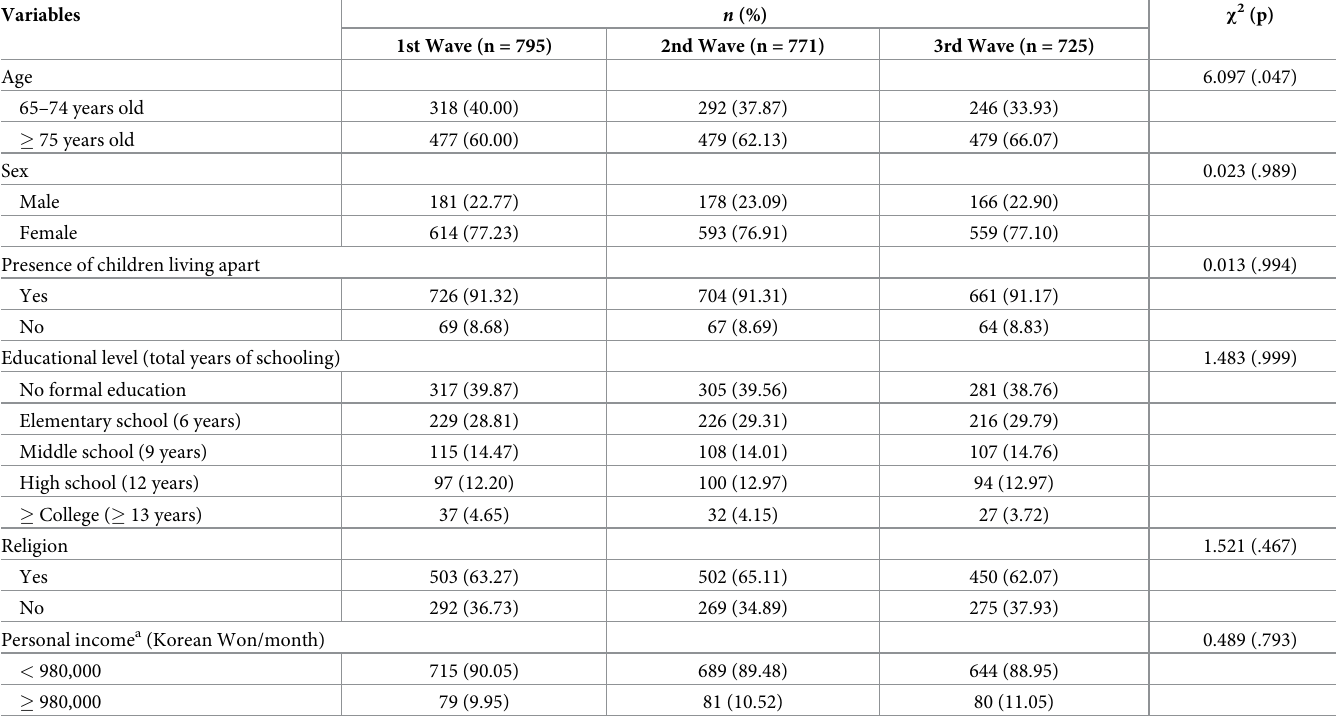
Table 1. Sociodemographic characteristics for the three waves (N =